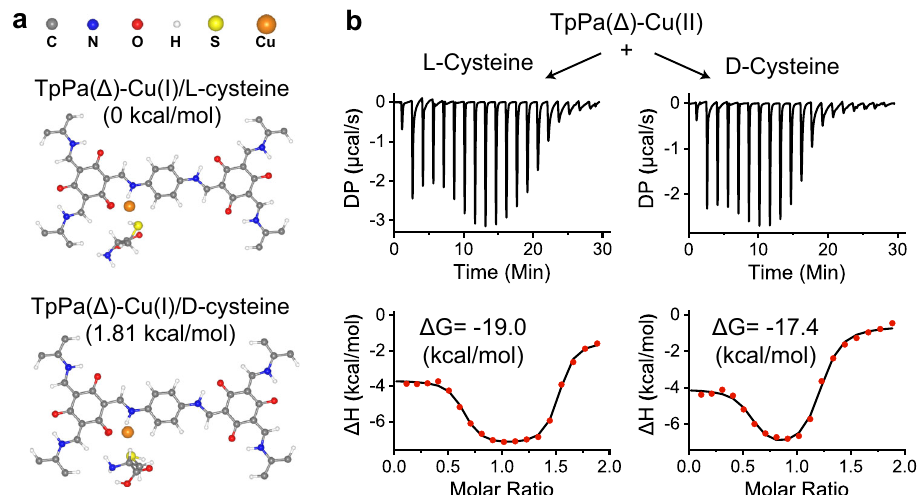
Fig.4|Bindingaf fi nitybetweenchiralCOFandcysteine.a Calculationofrelative Gibbs free energy for the binding of TpPa( Δ )-Cu(I)-COF model with L-/D-cysteine, respectively. b ITC thermogram resulting from titration of a TpPa( Δ )-Cu(II)-COF